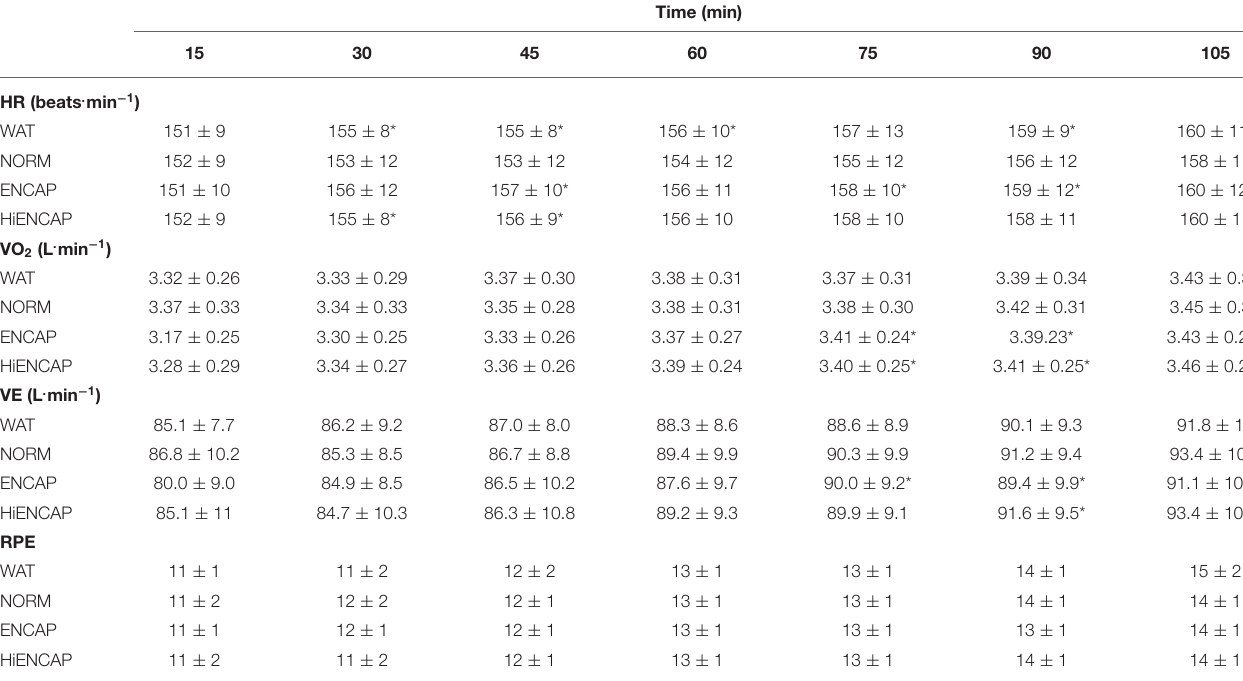
TABLE 1 | Cardiorespiratory variables collected during a 105min run at 71 ± 4% VO 2